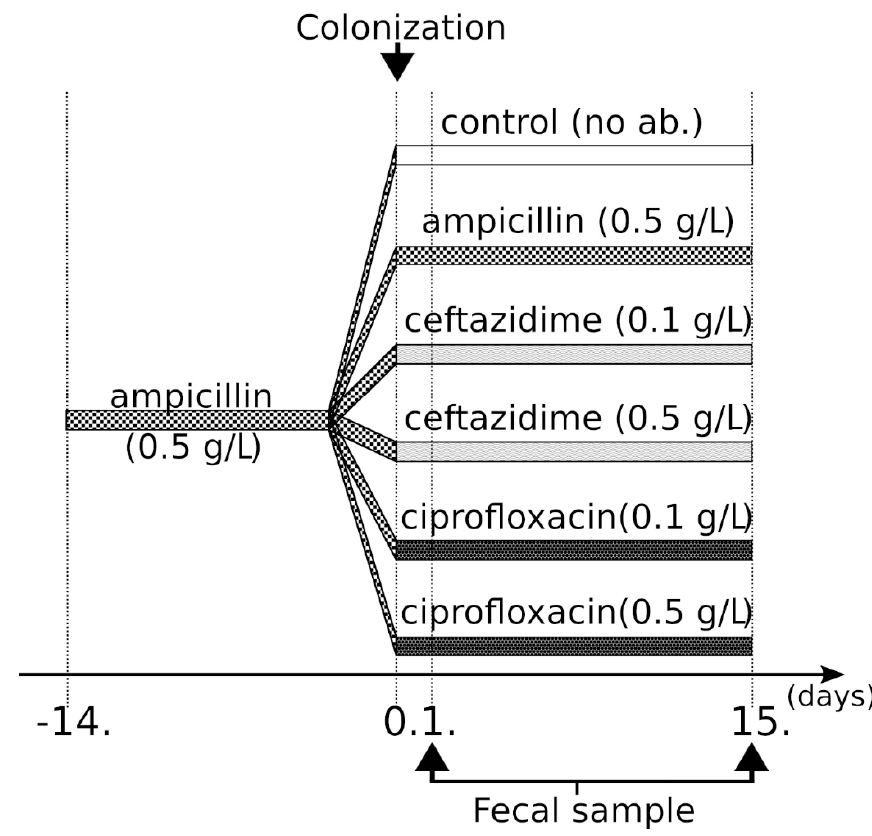
Figure 10. Colonization protocol used in our experiments .